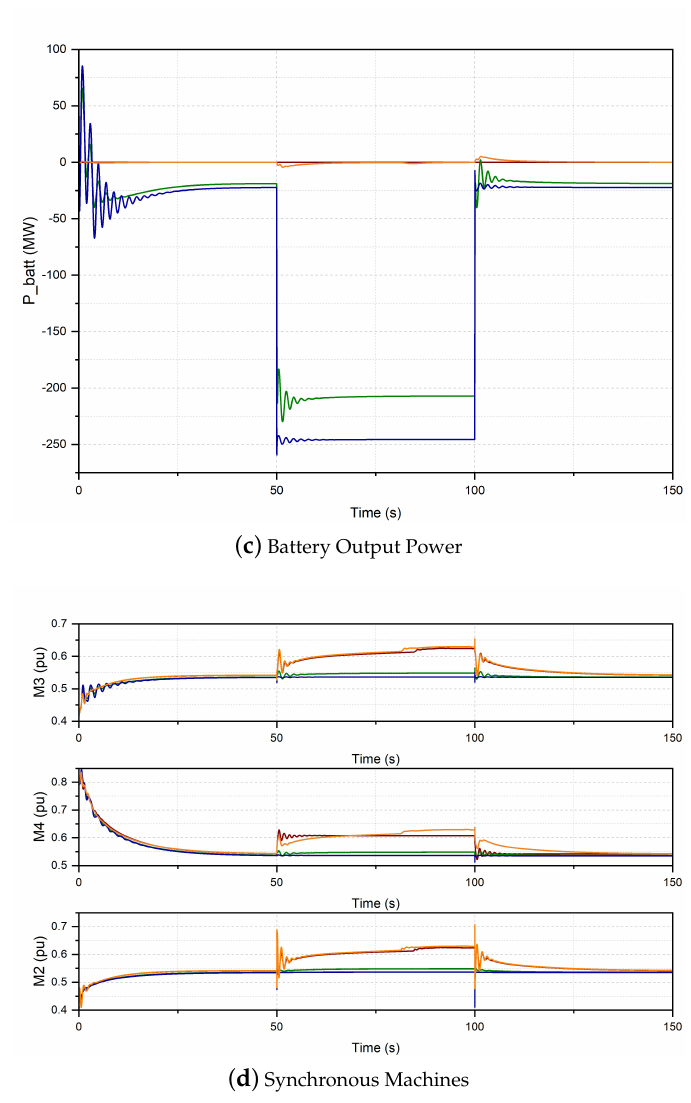
Figure 6. Variations in grid frequency, WTs’, and synchronous machines’ responses for different wind-battery combined control